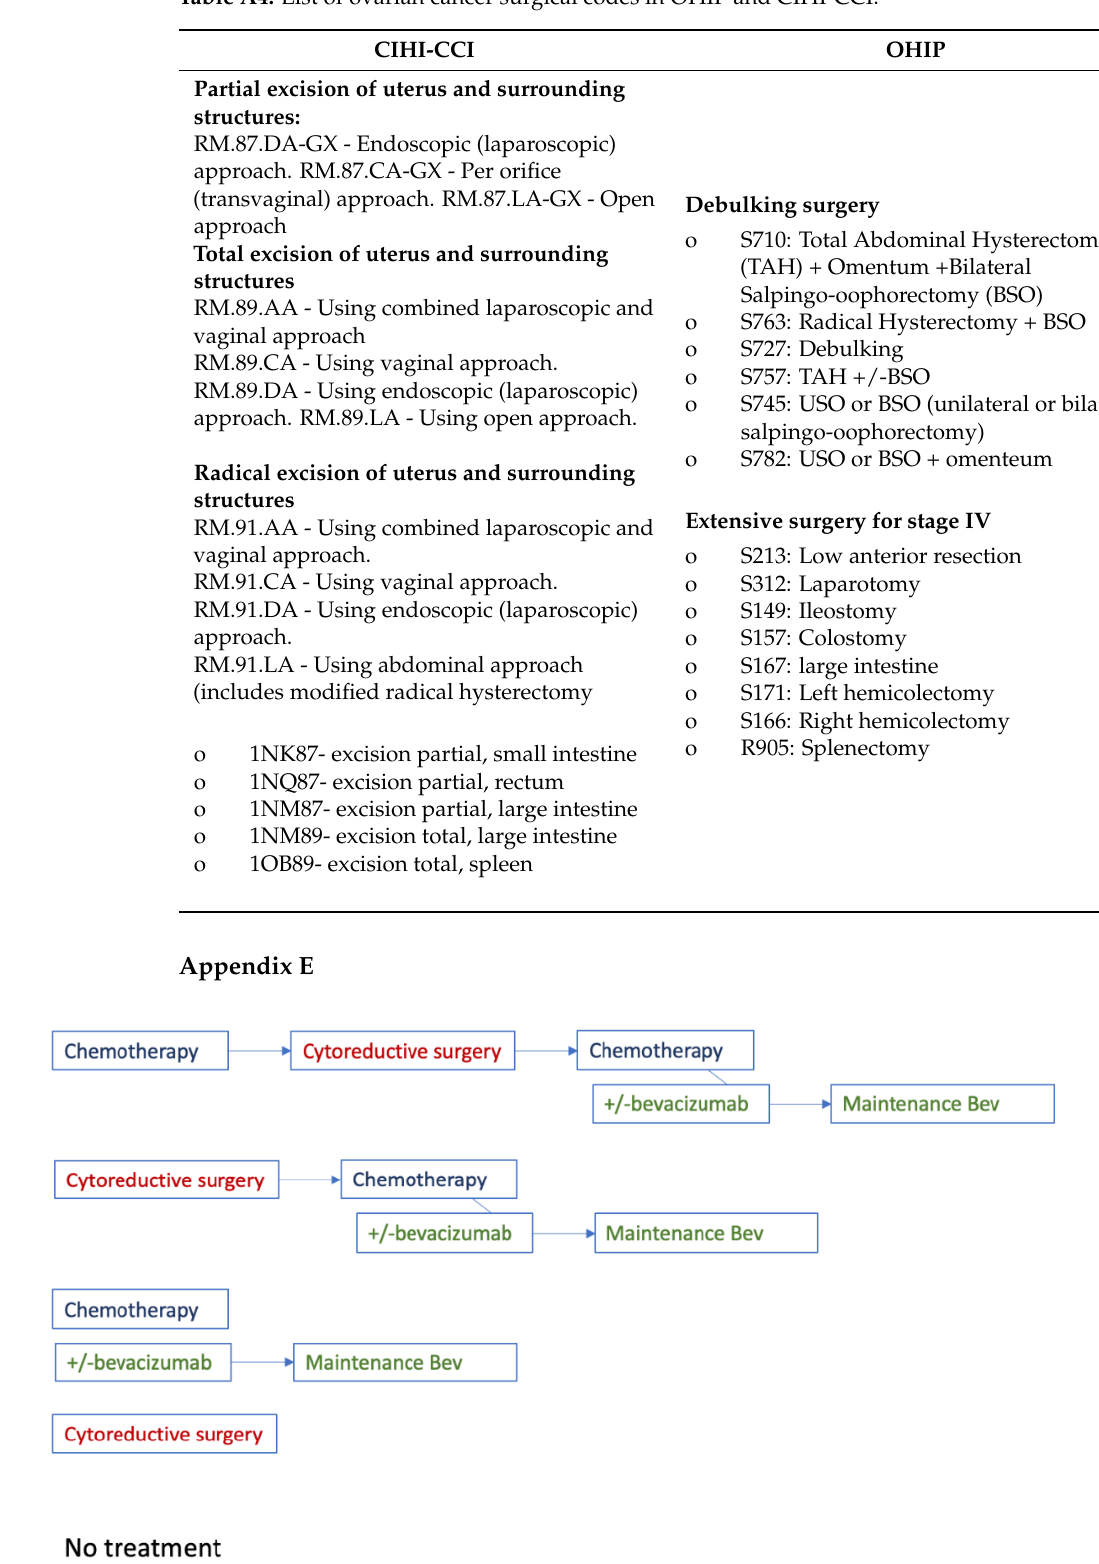
Figure A3. Treatment cohorts A – E.